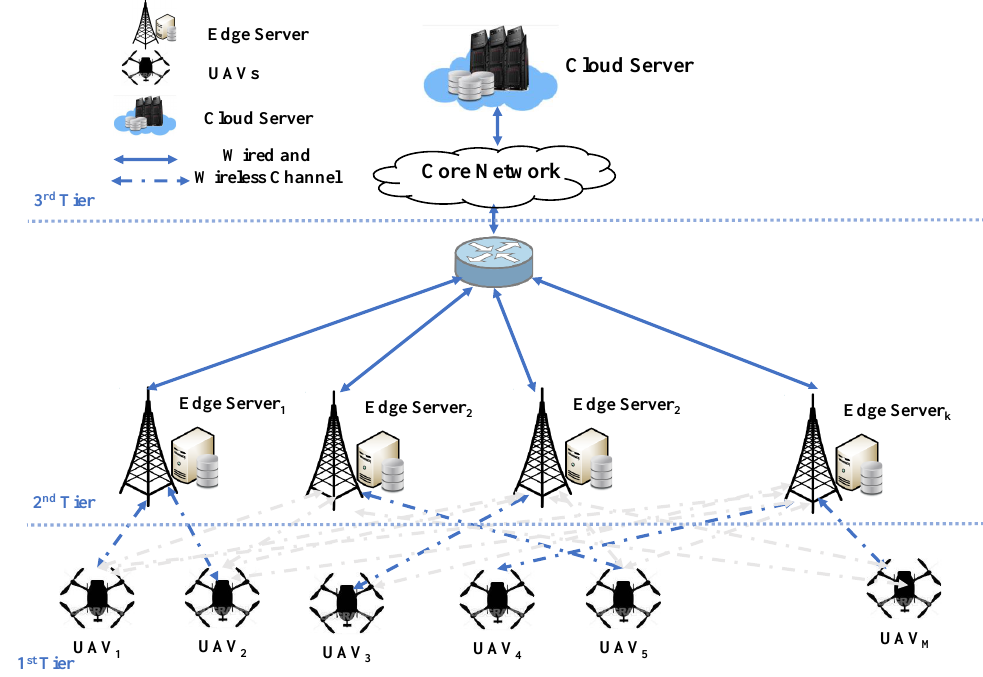
Figure 1. System